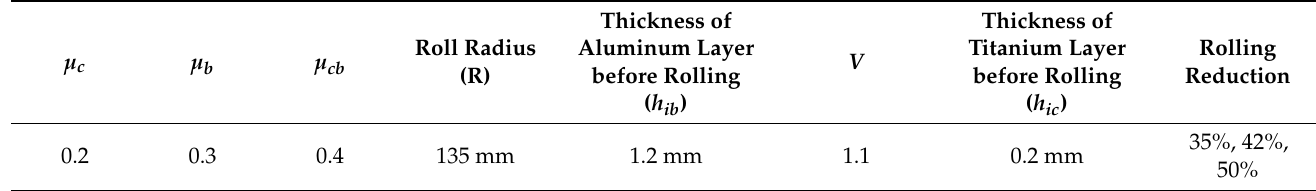
Table 3. Cold-rolling experimental parameters for model